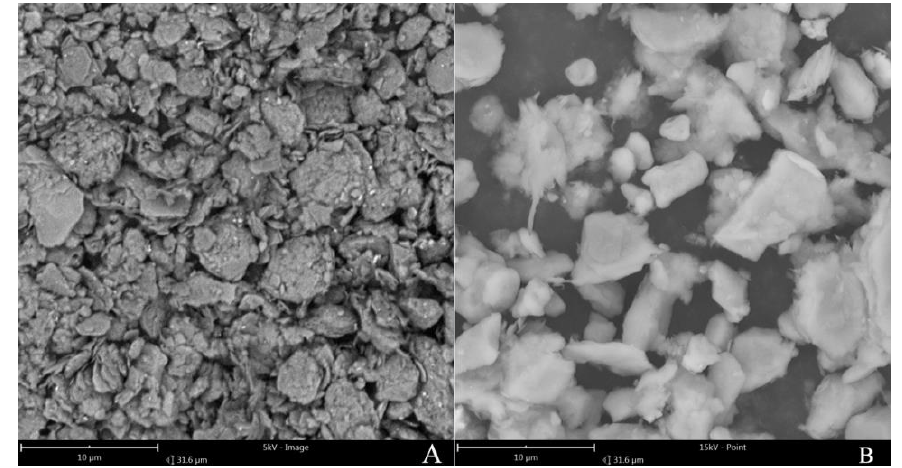
Figure 2. ( A ) SEM micrograph of nano I-S m (before adsorption); ( B ) after Pb (II) adsorption.